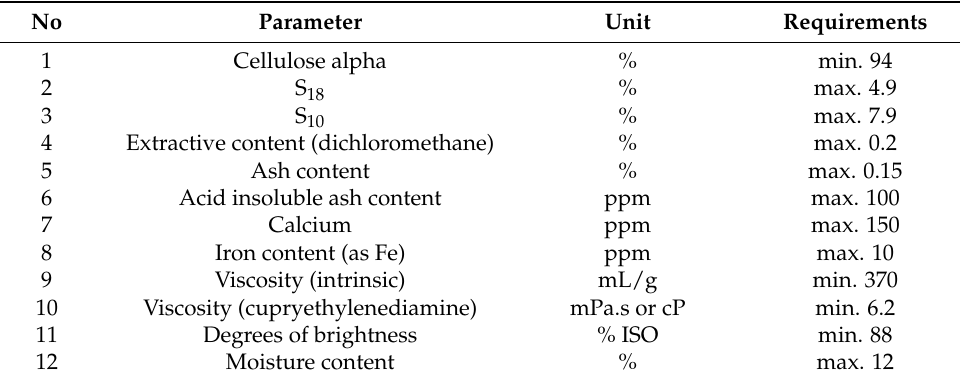
Table 6. Dissolving pulp (DP) quality standard based on Indonesian National Standard (SNI) number 938-2017.